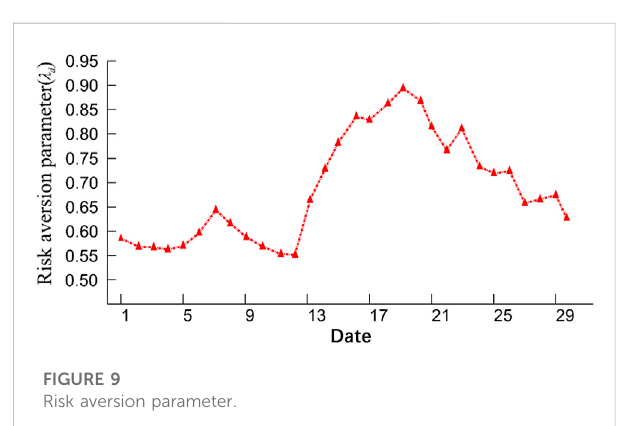
FIGURE 9 Risk aversion